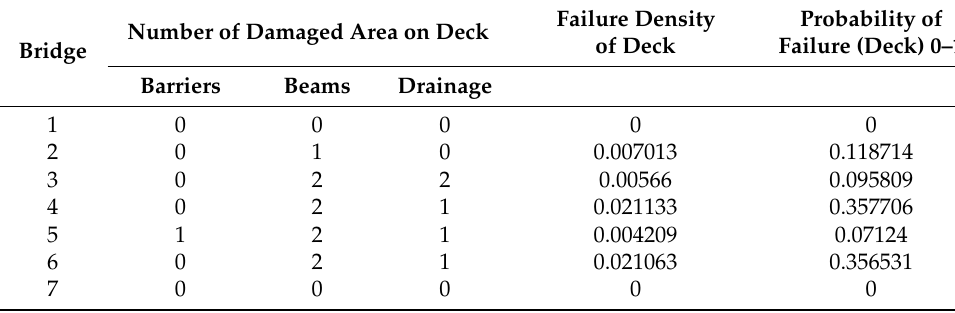
Table 2. Superstructure probability of failure for risk assessment.